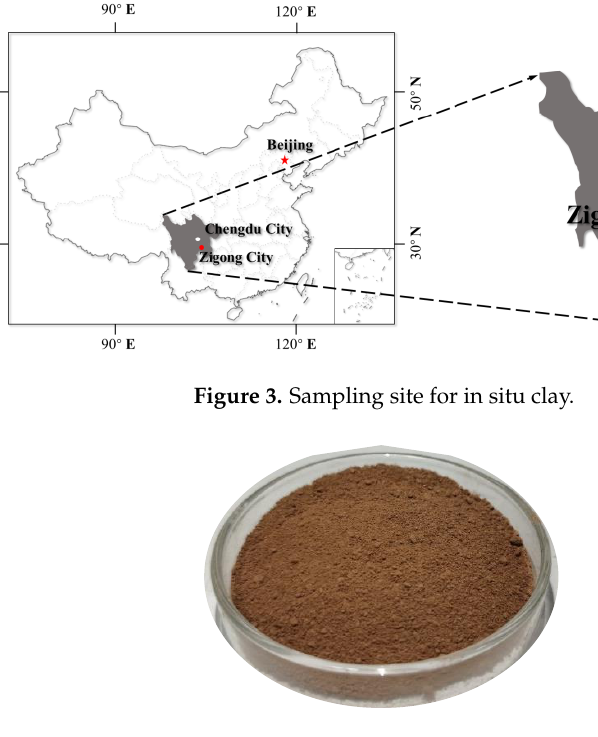
Figure 4. Picture of in− situ clay.